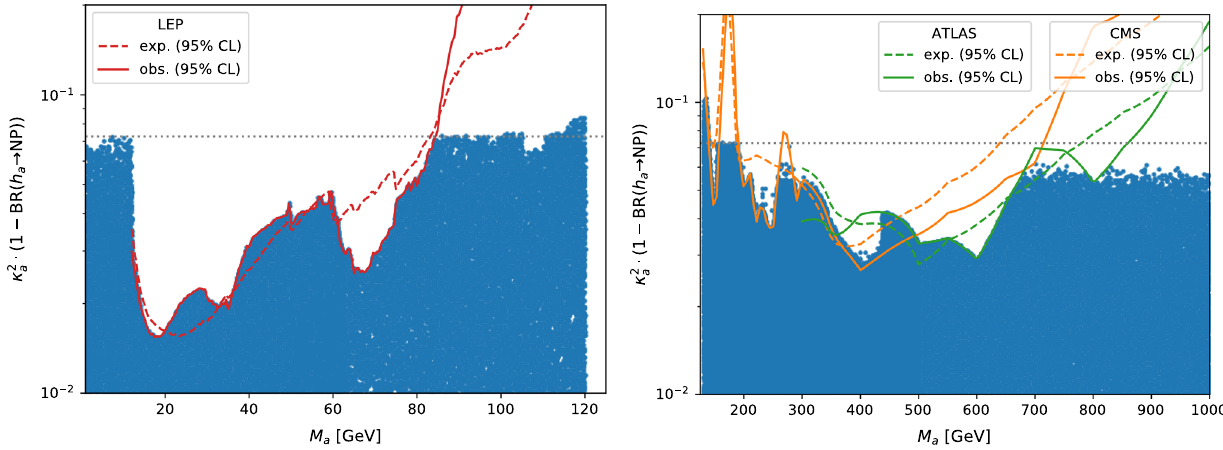
bbZ channel [120]. In the high mass region (right panel) the ATLAS [121] and CMS [122] observed and expected limits from the latest pp → h a → Z Z / WW searches are displayed. The dotted gray line indicates the indirect limit on κ 2 from Higgs rate measurements